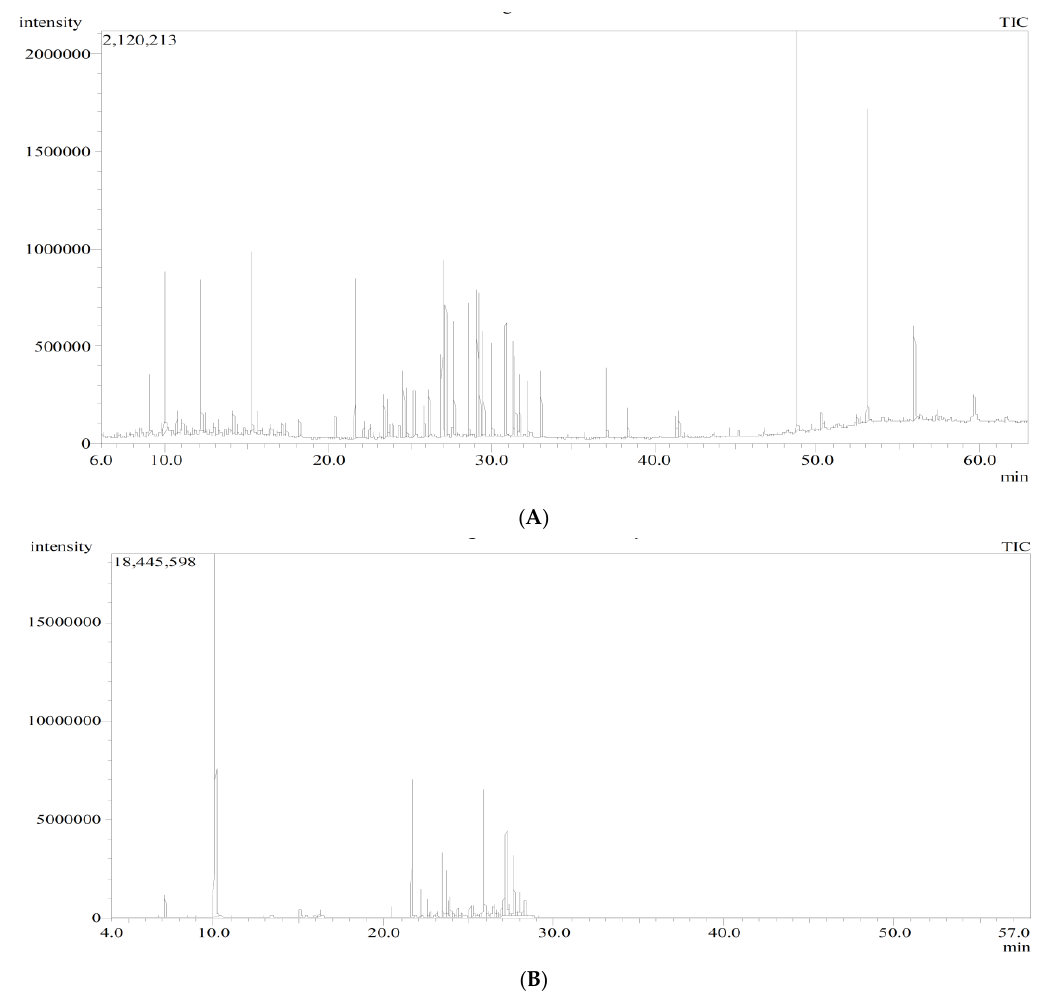
Figure 1. GC chromatogram of ( A ) n -hexane extract and ( B ) essential oil of P. guajava leaves.